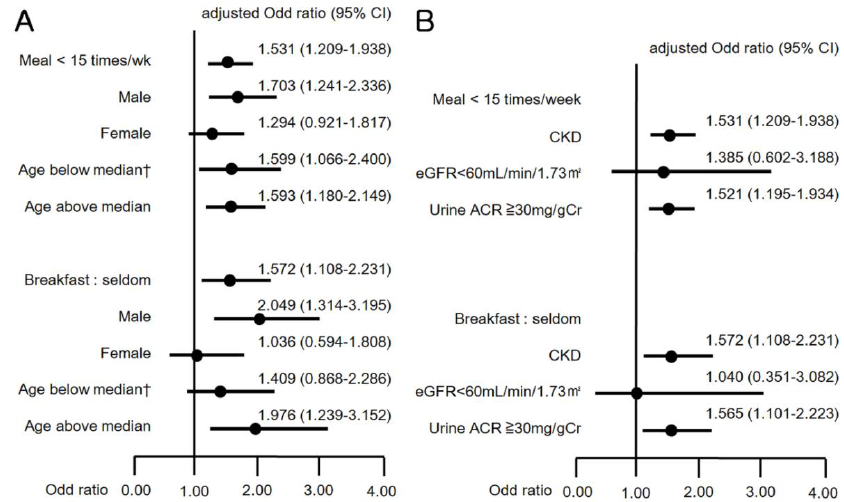
Figure 3. ( A ) Odds ratios (95% CI) for CKD by subgroup analysis with gender and age; and ( B ) Odds ratios (95% CI) for CKD by subgroup analysis with eGFR and urine albumin-creatinine ratio (ACR). † Old cerebrovascular accident not included in the analysis. Table 4. Subgroup analysis using the complex samples multivariate logistic regression for CKD by meal frequency, breakfast frequency, and self-reported daily calorie